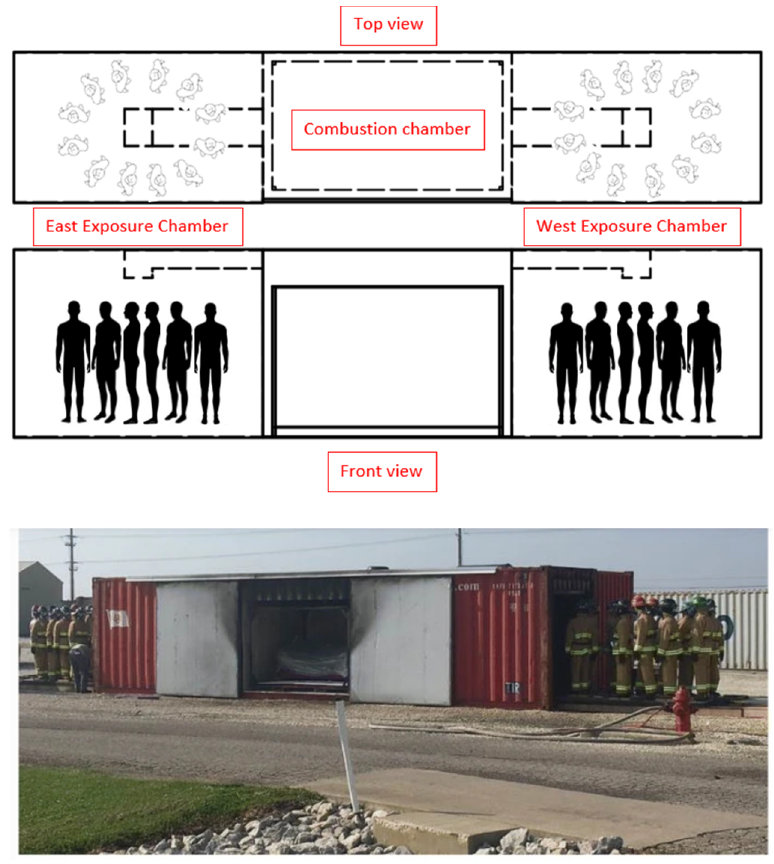
Figure 1. Fire Exposure